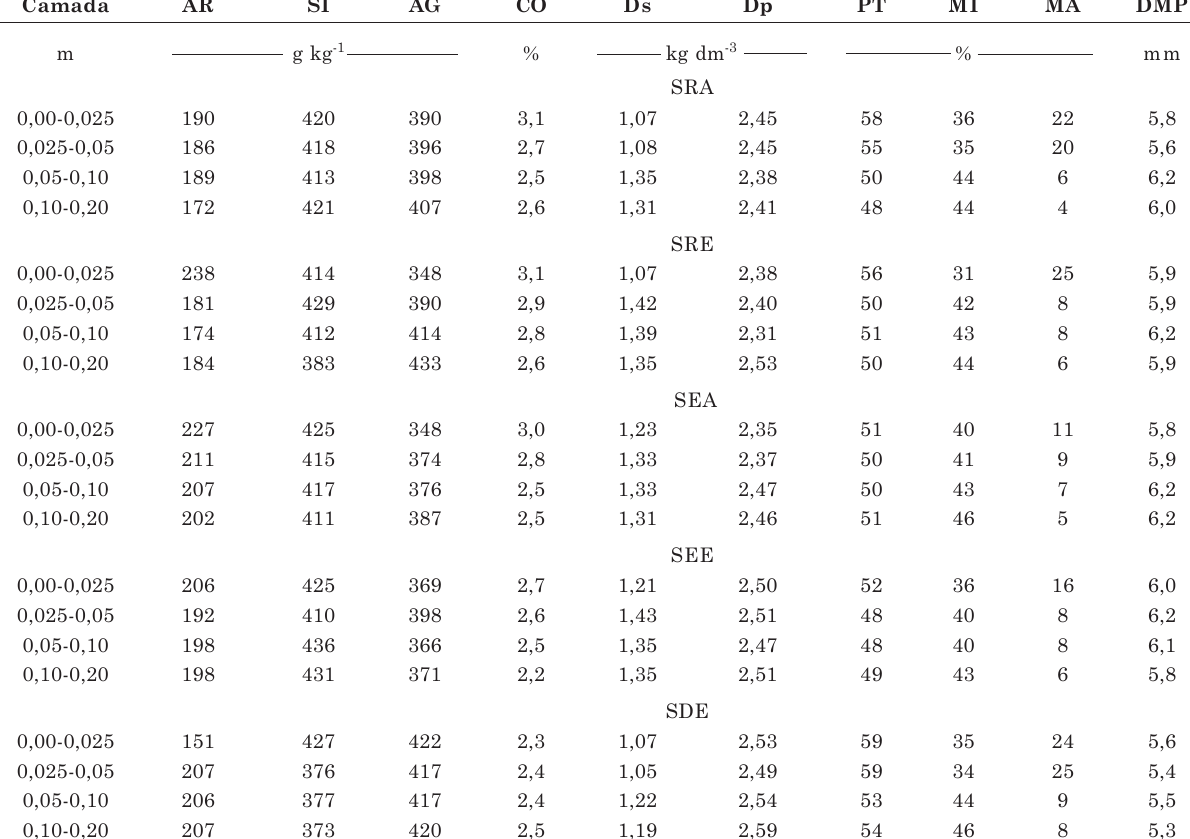
Quadro 1. Teores de areia (AR), silte (SI), argila (AG) e carbono orgânico (CO), densidade do solo (Ds), densidade das partículas (Dp), porosidade total (PT), macroporosidade (MA), microporosidade (MI) e estabilidade dos agregados em água (DMP) para as camadas de 0,00-0,025; 0,025-0,05; 0,05-0,10; e